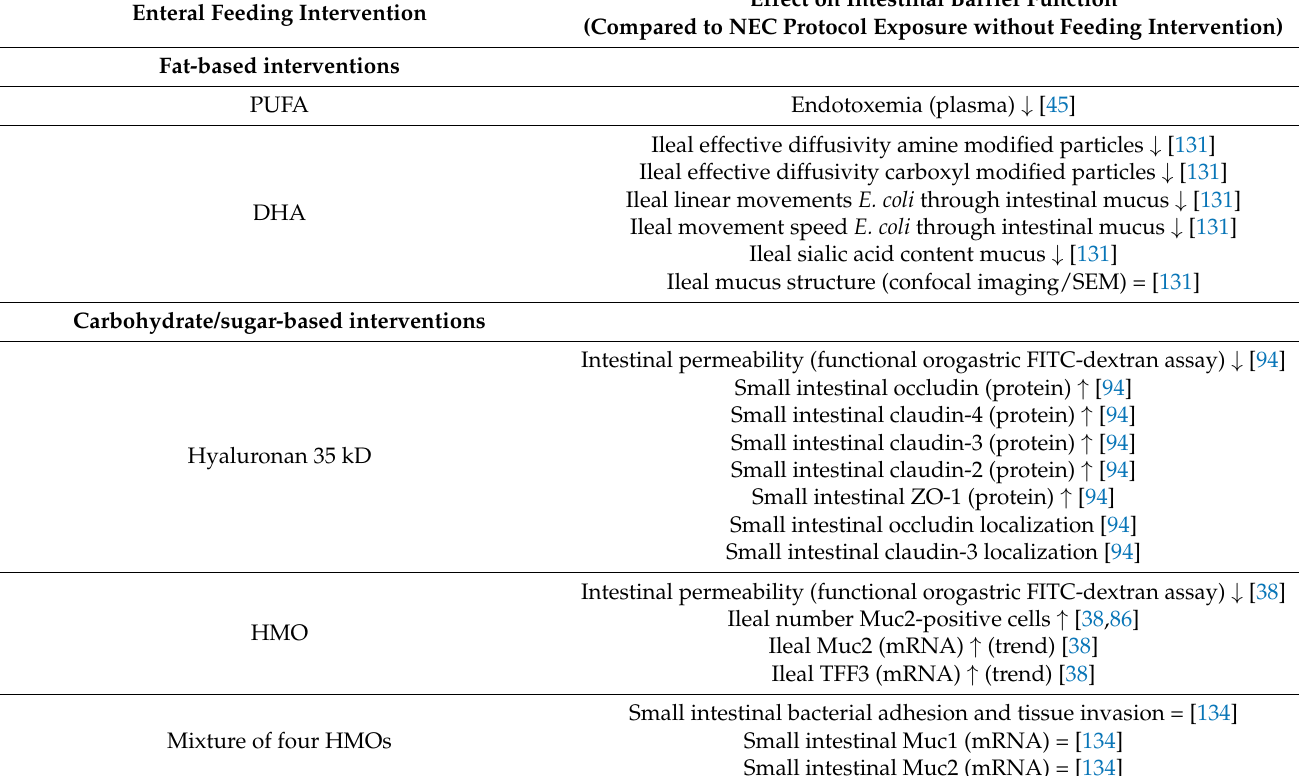
Mixture of four